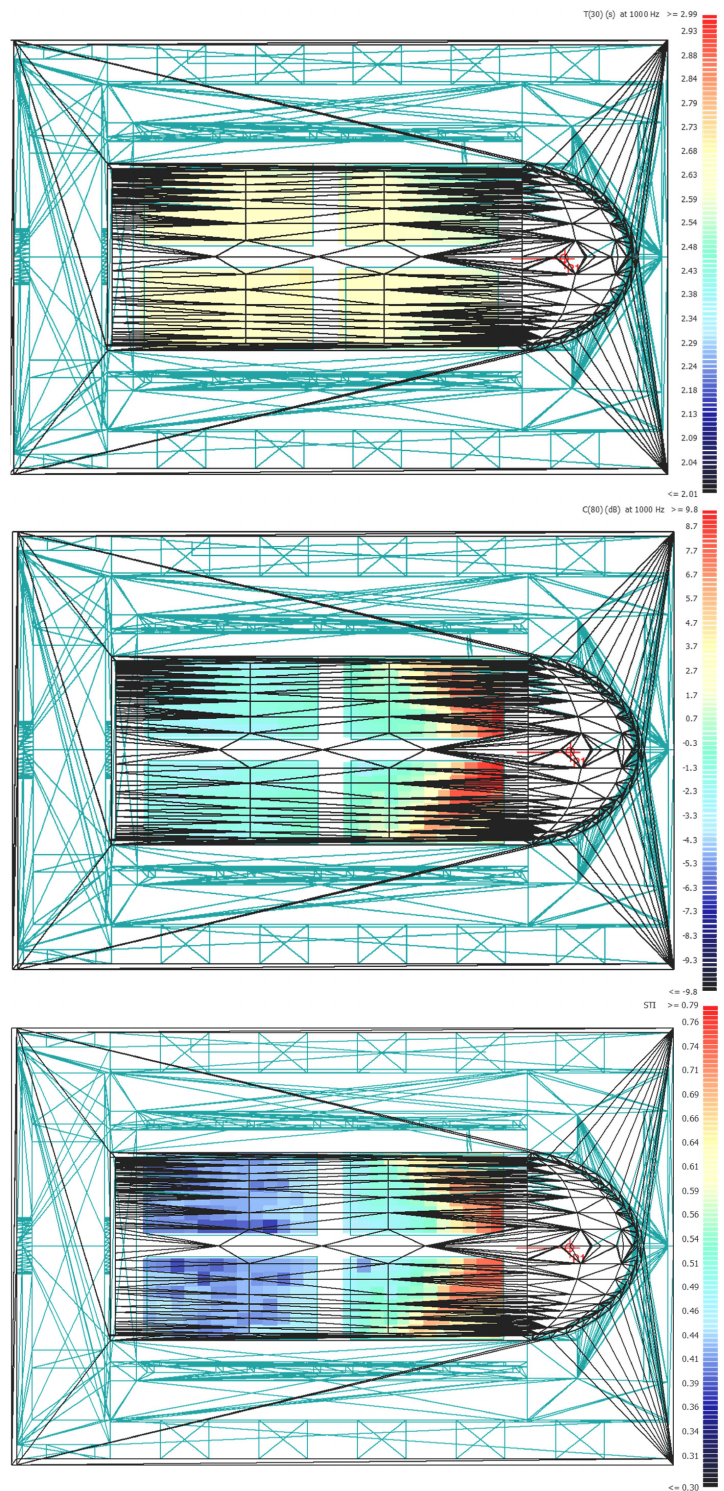
Figure 8. Color maps at 1 kHz of the T 30 , C 80 , and STI in the configuration with the audience and the acoustic treatments heavy curtain banners (the maps only cover the area where the audience